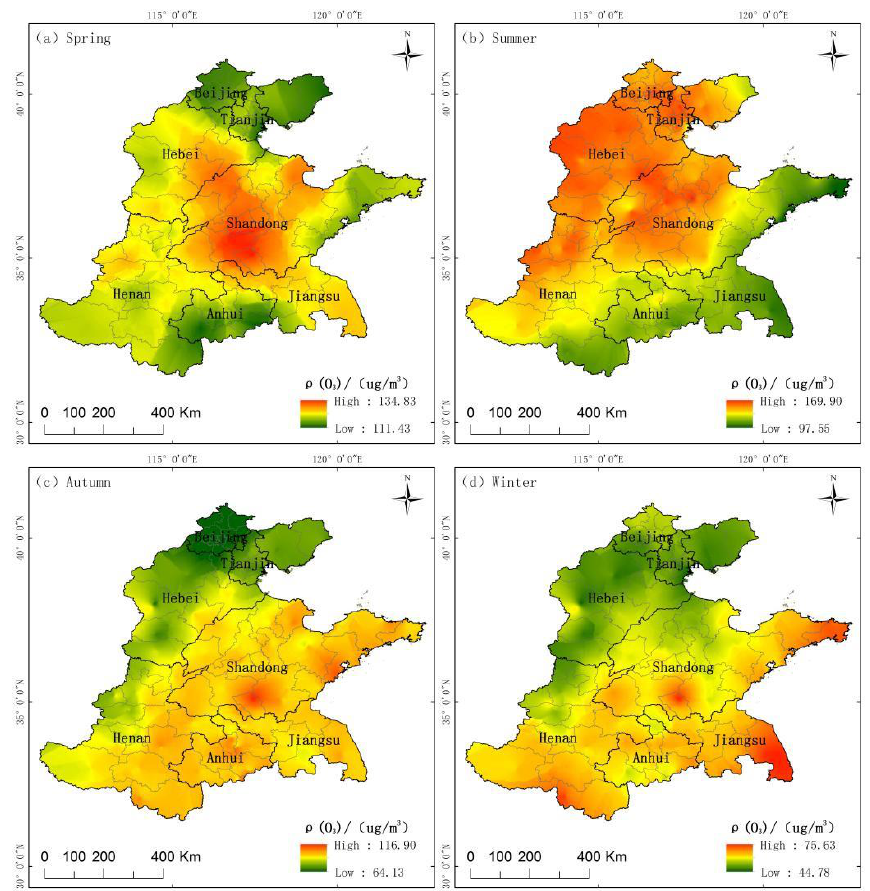
Figure 7. Seasonal spatial distribution map of O 3 in the NCP from 2016 to 2020: ( a ) Spatial distribution of O 3 in spring, ( b ) Spatial distribution of O 3 in summer, ( c ) Spatial distribution of O 3 in autumn, ( d ) Spatial distribution of O 3 in winter.